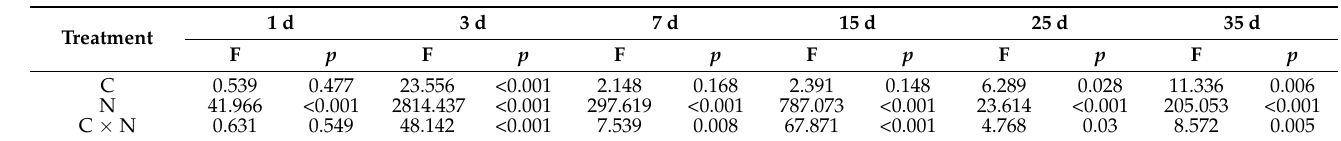
Table 3. ANOVA of the nitrogen mineralization rate of saline soil with the return of straw and the application of nitrogen.